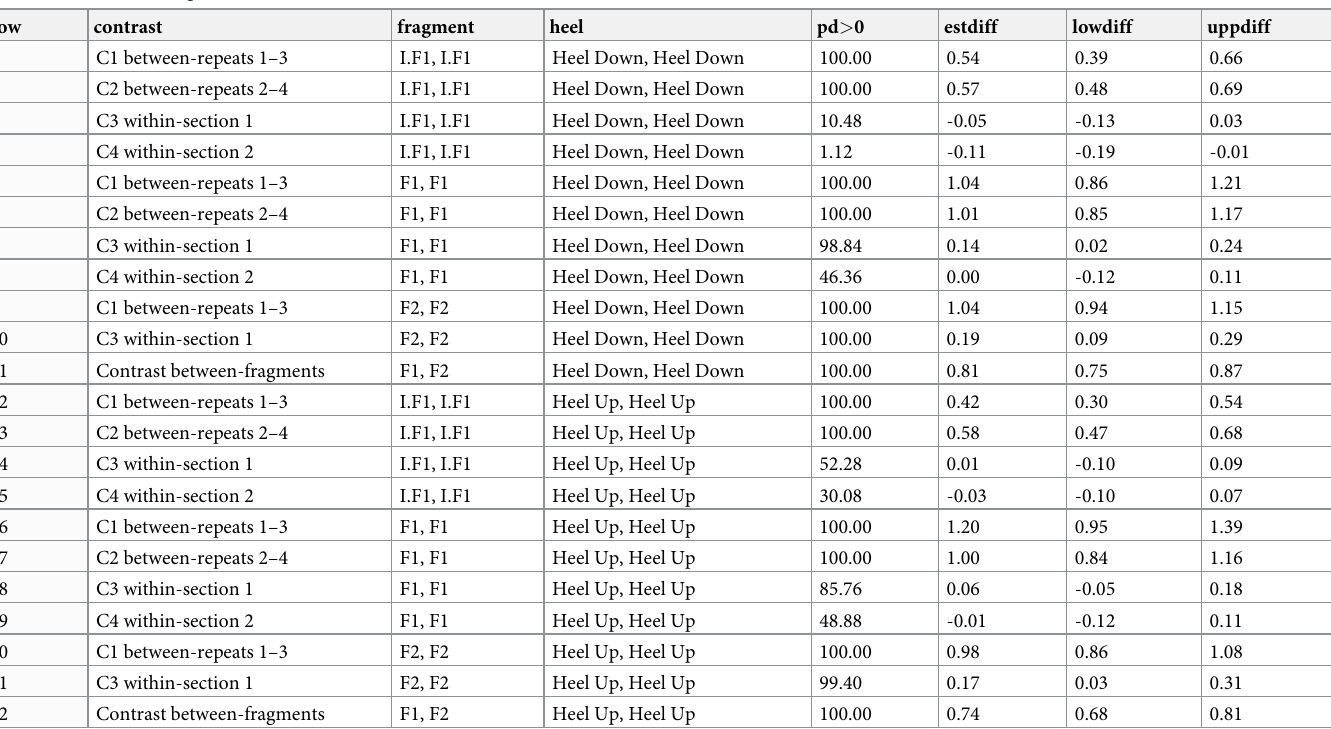
Table 5. Contrasts of